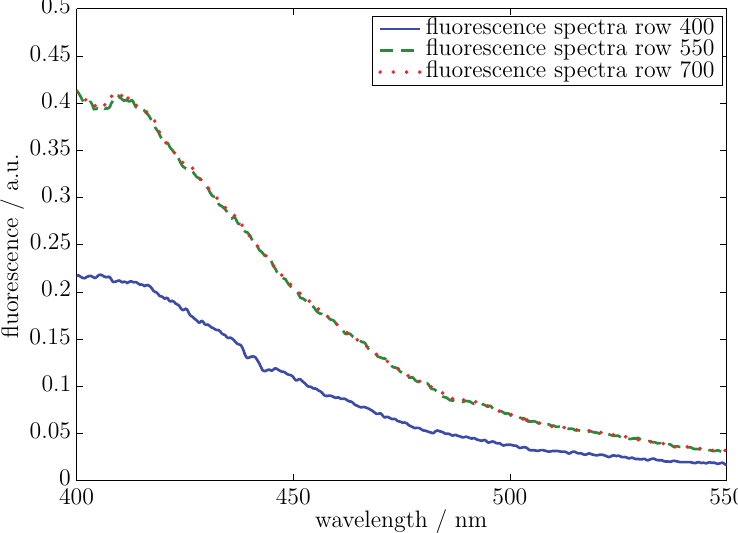
Figure 6. Static measured hyperspectral fluorescence spectra of a viscous material with a non-fluorescent impurity. Exemplary fluorescence spectra of rows 400, 550 and 700. The non-fluorescent impurity is in the area of row 400 on the CMOS 2D sensor